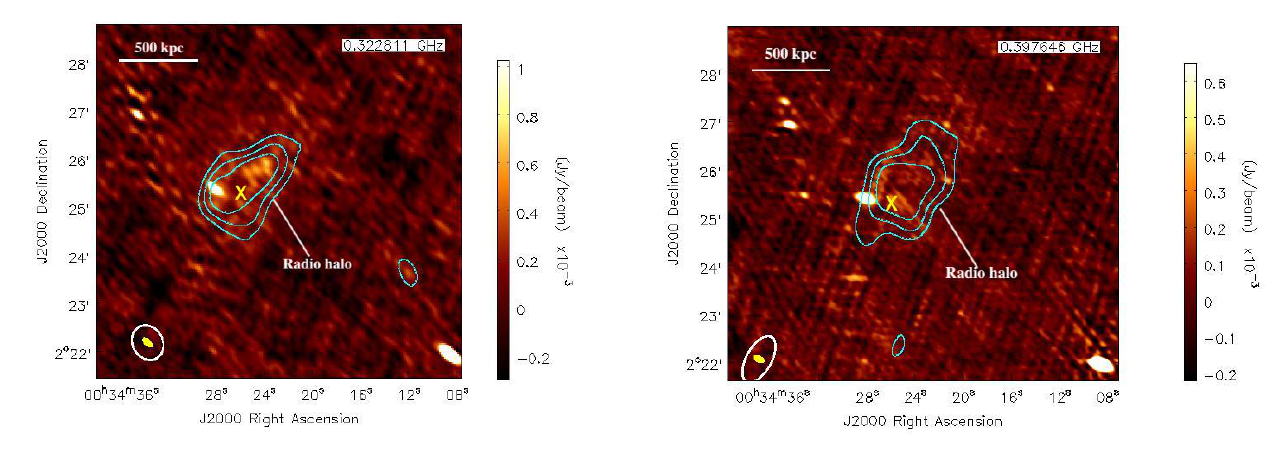
Figure 5. Left : Full resolution GSB image of J0034, which has a rms of 75.8 µ Jy/beam. The contours are from the low resolution point-source-subtracted image. The rms ( σ ) of the low resolution image is 0.58 mJy/beam and the contour levels are σ × [ − 3,3,4,6]. The yellow cross indicates the ACT SZ peak. The beam sizes of the full resolution and the low resolution images are shown at lower left by the yellow and white ellipses, respectively. The beam sizes of the full resolution and low resolution images are (18.1 (cid:48)(cid:48) × 14.2 (cid:48)(cid:48) , p.a. 48.2 ◦ ) and (44.6 (cid:48)(cid:48) × 37.1 (cid:48)(cid:48) , p.a. 28.6 ◦ ), respectively. Right : Full resolution GWB image of J0034 from the experimental SPAM pipeline. The rms in the cluster region is 45.9 µ Jy/beam. The contours are from the low resolution point-source-subtracted image. The rms of the low resolution image is 0.29 mJy/beam and the contour levels are σ × [ − 3,3,5,8]. The yellow cross indicates the ACT SZ peak. The synthesised beam for the full resolution and the low resolution images are shown by the yellow ellipse and the white ellipse, respectively. The synthesised beam for the full resolution and low resolution images are (14.0 (cid:48)(cid:48) × 7.6 (cid:48)(cid:48) , p.a. 65.3 ◦ ) and (43.5 (cid:48)(cid:48) × 31.1 (cid:48)(cid:48) , p.a. 150.7 ◦ ),